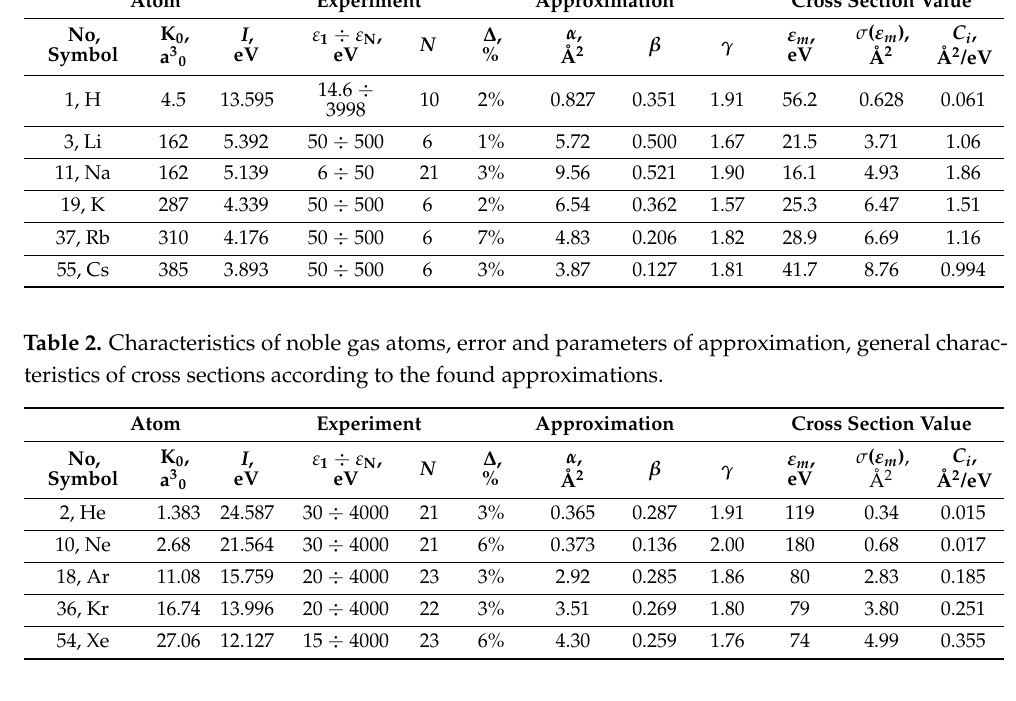
Table 3. Characteristics of atoms of transition metals, error and parameters of approximation, general characteristics of cross sections according to the found